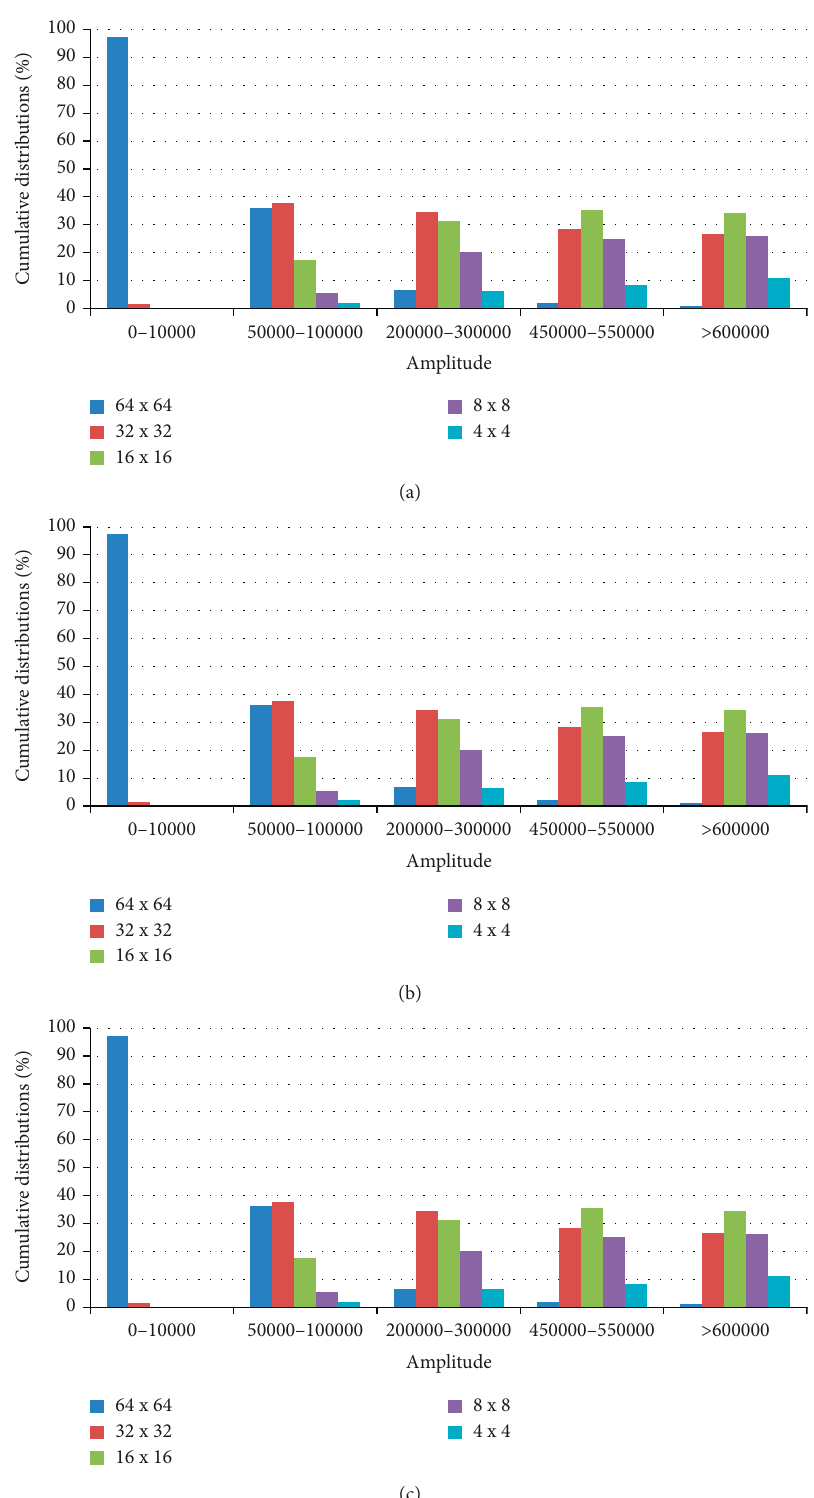
Figure 5: The histogram distribution size of the depth map CTU according to the amplitude and QP � 34. (b) QP � 39. (c) QP � QP DepthMap DepthMap DepthMap